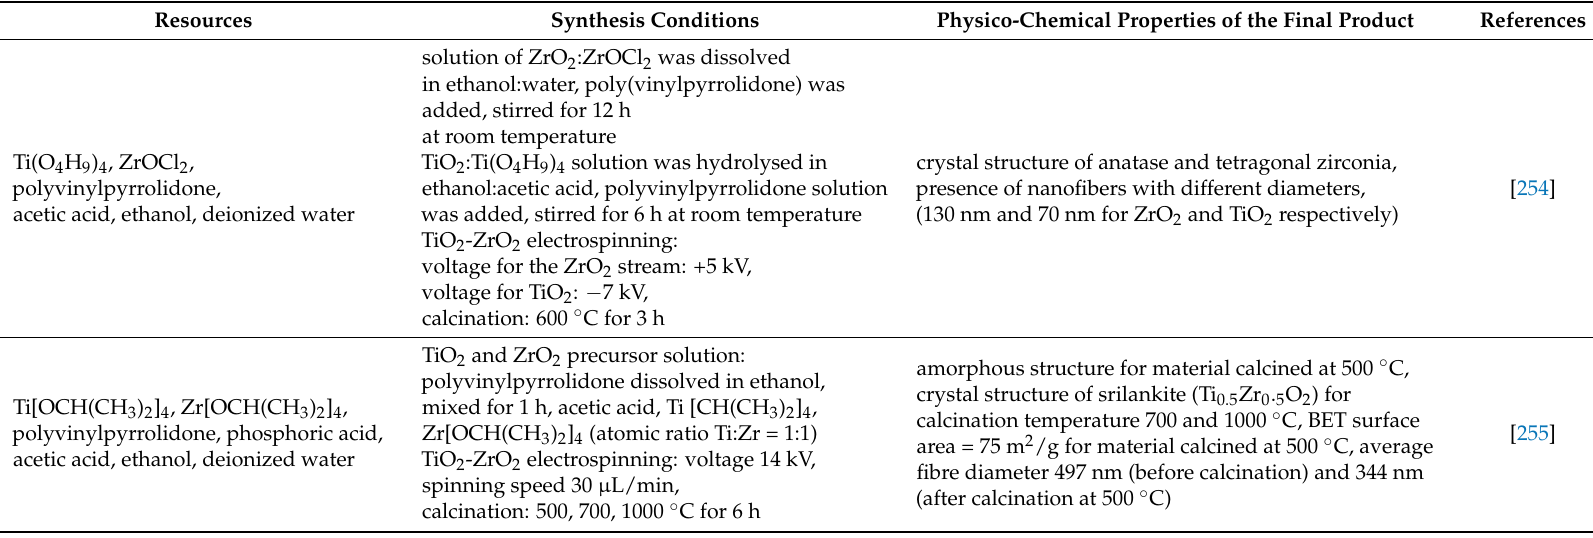
Table 8. Resources, synthesis conditions and physico-chemical properties of TiO 2 -ZrO 2 oxide systems obtained by the electrospinning